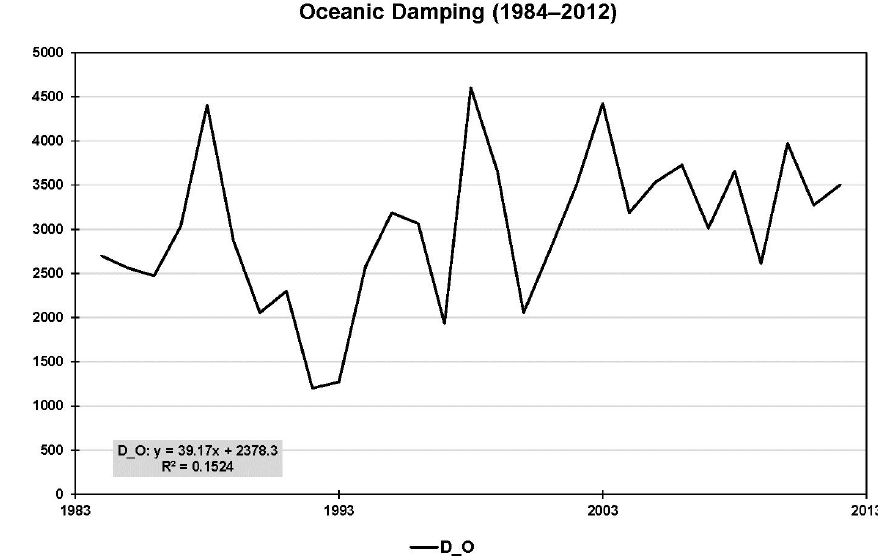
Figure 4. Oceanic carbon uptake perceived as damping (in ppmvyr) based on observations at seven ocean carbon time series sites for periods from 15 to 30 years (between 1983 and 2012). The linear trend in oceanic damping, shown at the bottom, is used to interpret damping as a constant with appropriate uncertainty (given by half the maximal